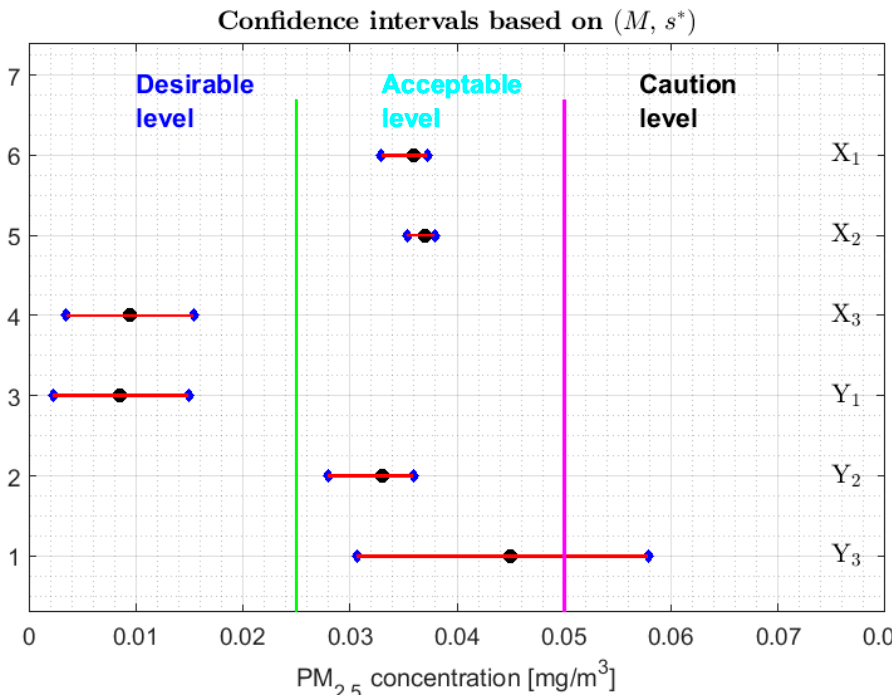
Figure 10. 95% confidence intervals based on ( M , s ∗ ) , and the bands that delimit the three lowest categories of air pollution by PM 2.5 concentrations in Quito. Median: Black circle; Ends of the intervals: Blue diamonds.